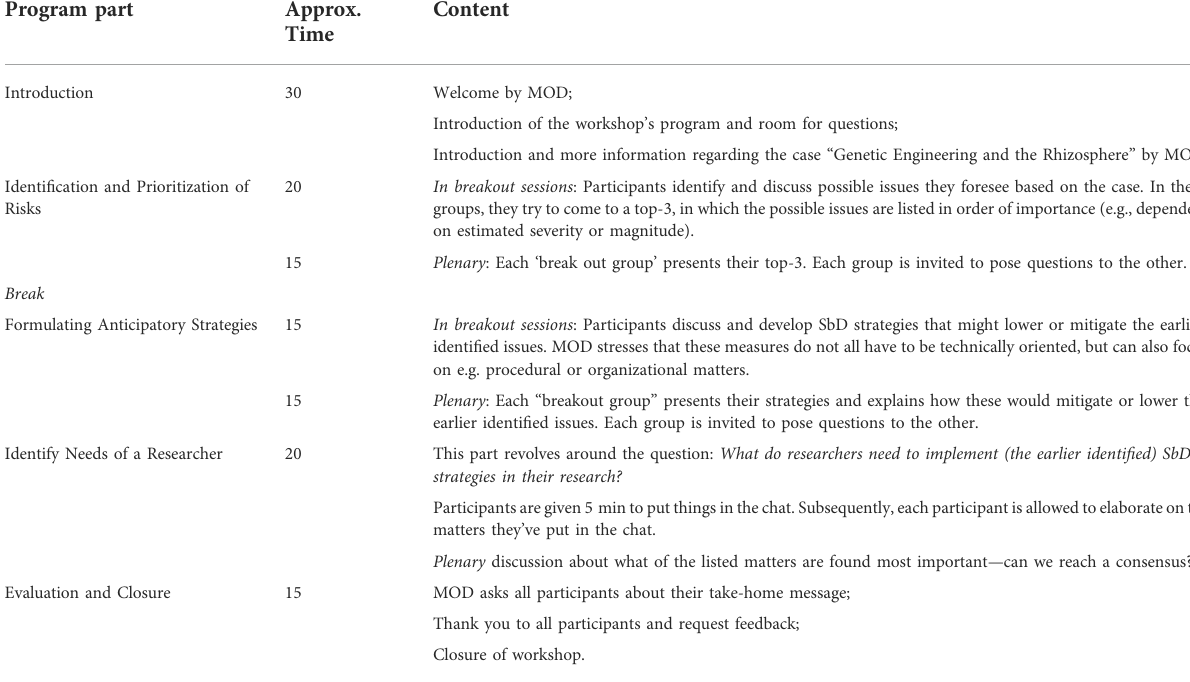
TABLE 2 Script for Workshops conducted in January and February 2022. MOD = Moderator of the